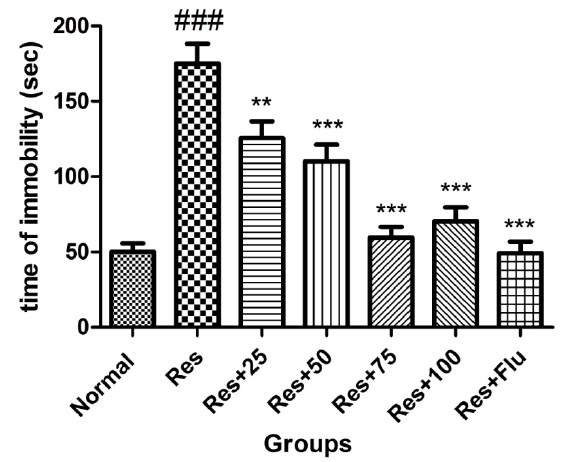
Figure 1. The effect of intraperitoneal injection of four different concentrations of K. odoratissima Mozaffarian extract (25, 50, 75, and 100 mg/kg) on immobility time in mice. Flu= Fluoxetine, Res=reserpine. # Vs. normal group ( ### P < 0.001), * Vs. reserpine- receiving group ( ** P < 0.01, *** P <